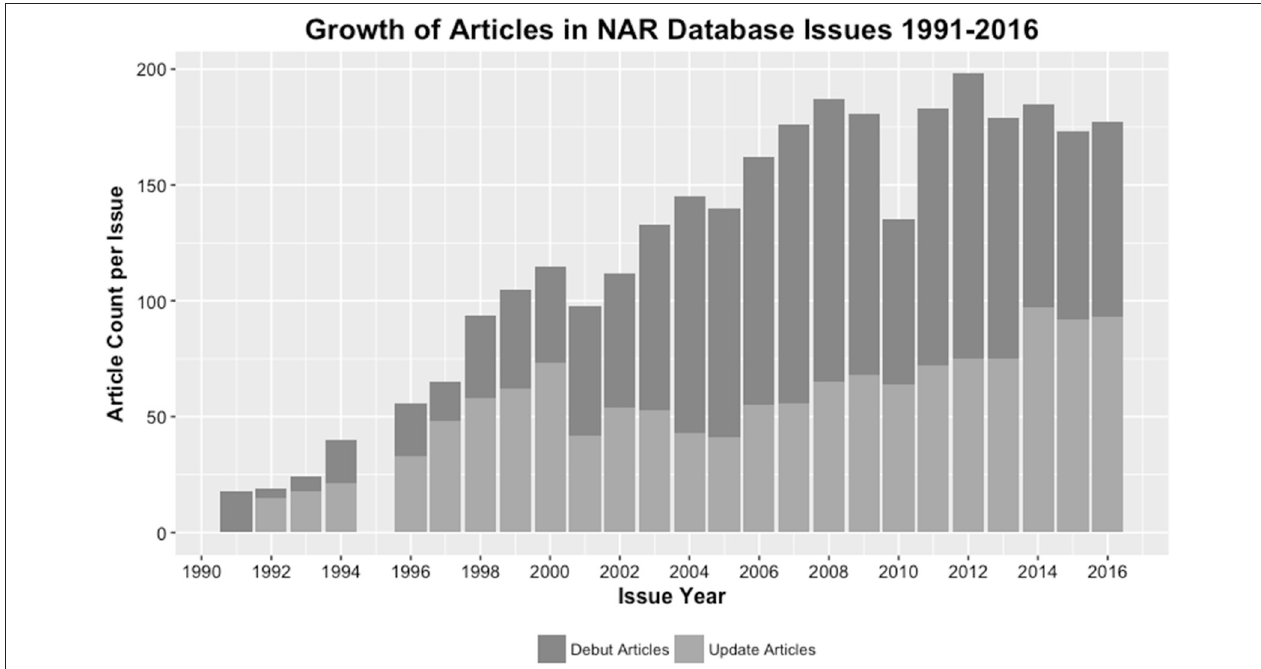
FIGURE 1 | NAR Database Issue growth between 1991 and 2016. Stacked bars represent the total number of articles published in a given year and are further broken down into debut articles (dark gray) and update articles (light gray). Note that here (and figures throughout), the absence of data for 1995 is the result of no publication of a Database Issue that year.